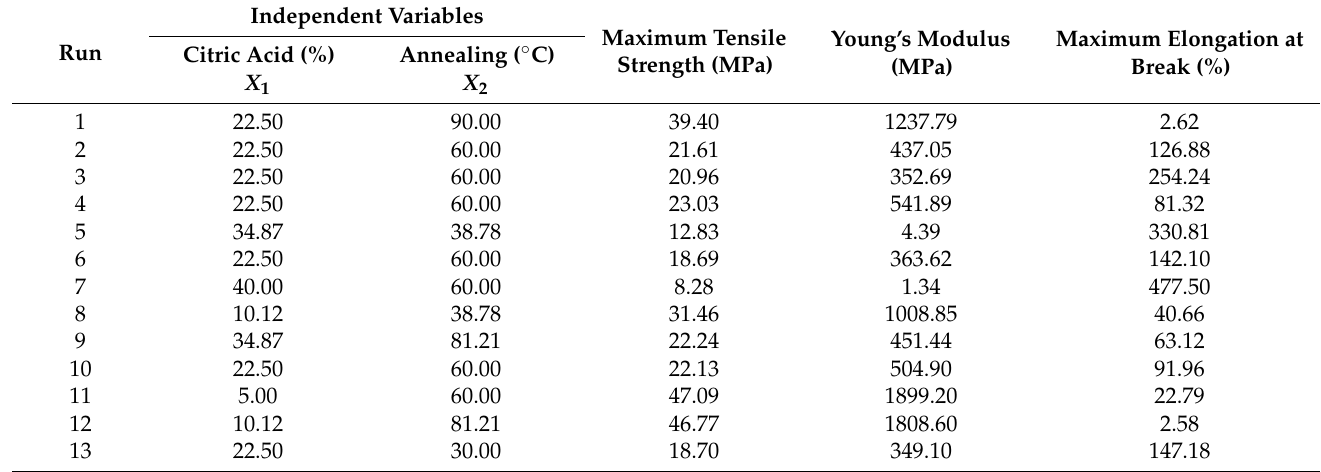
Table 1. Results of mechanical properties in central composite